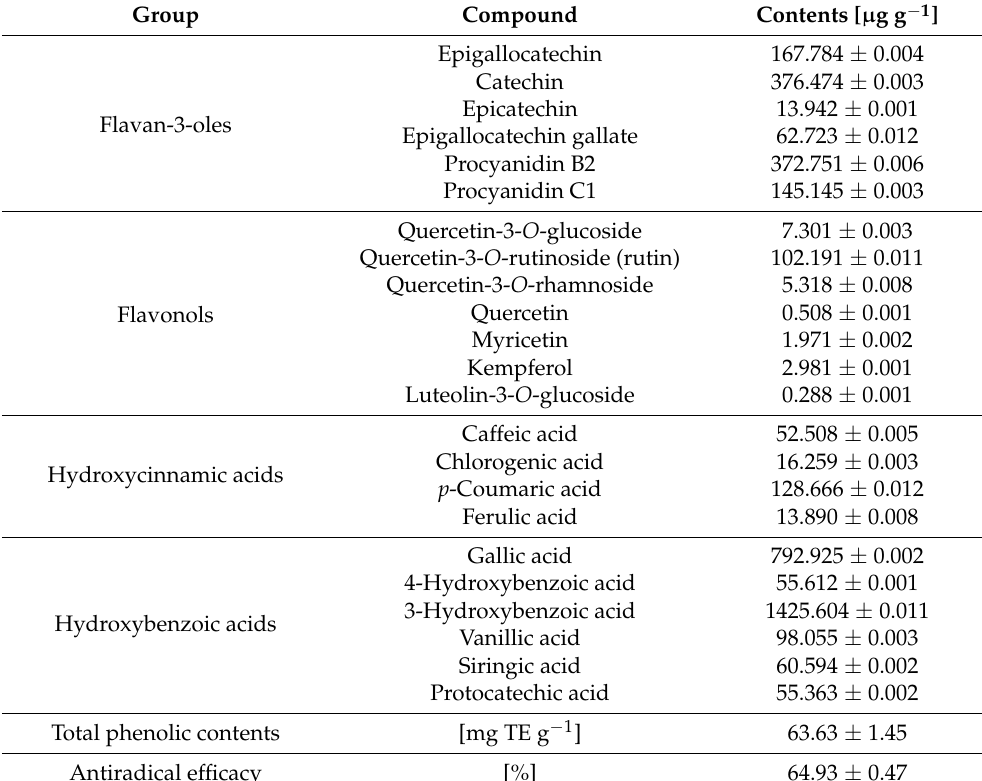
Table 1. Phenolic compounds, total phenolic compounds, and antiradical efficacy of the goji berries– water extract; results are presented as an average value of three repetitions with ±